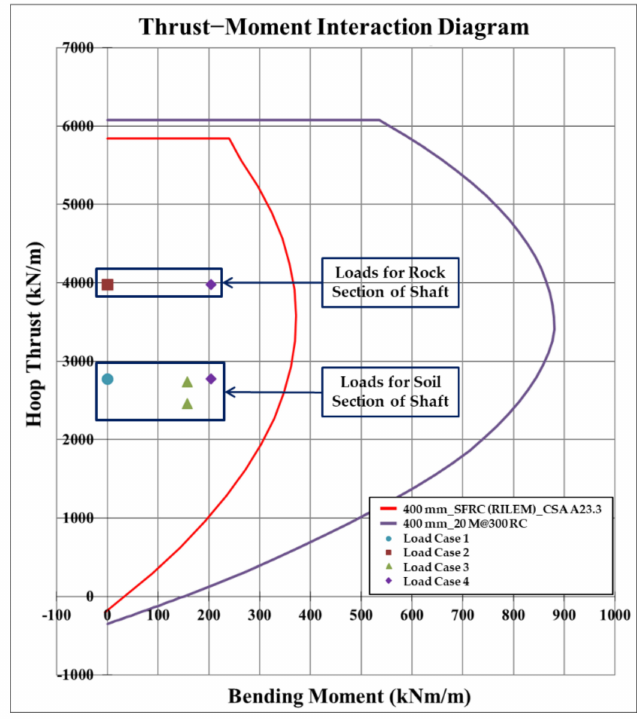
Figure 7. Thrust—Moment interaction diagram for the